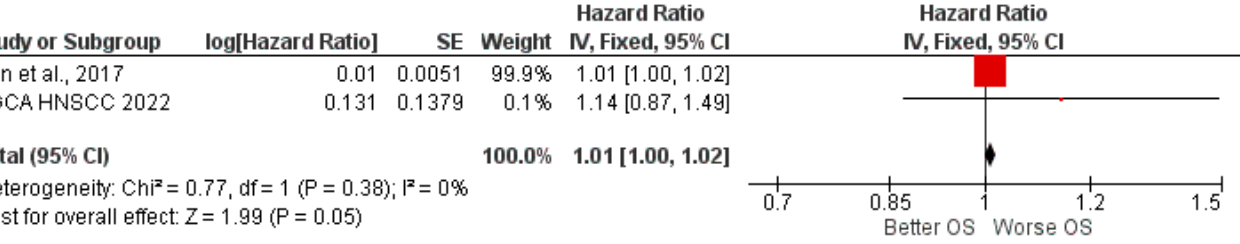
Figure 4 . Forest plot of the fixed-effects model of the meta-analysis: OS, HR = 1.01, 95% CI: [1.00, 1.02]; df = degrees of freedom; I 2 = Higgins heterogeneity index, I 2 < 50%, heterogeneity irrelevant; I 2 > 75%, significant heterogeneity; C.I. = confidence intervals; P = p -value; SE = standard error. The